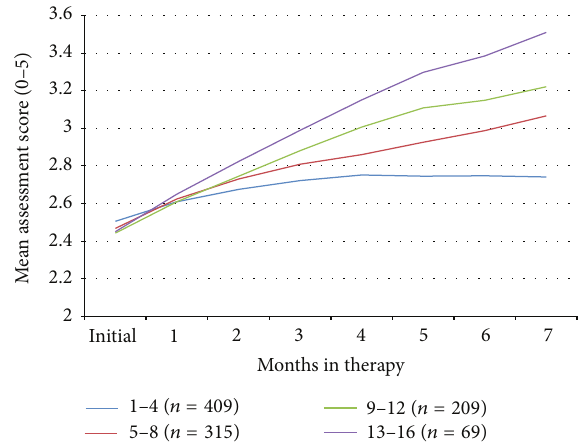
Figure 3: Mean composite assessment score (scale 0–5) over time for subjects whose parents downloaded different numbers of exercise